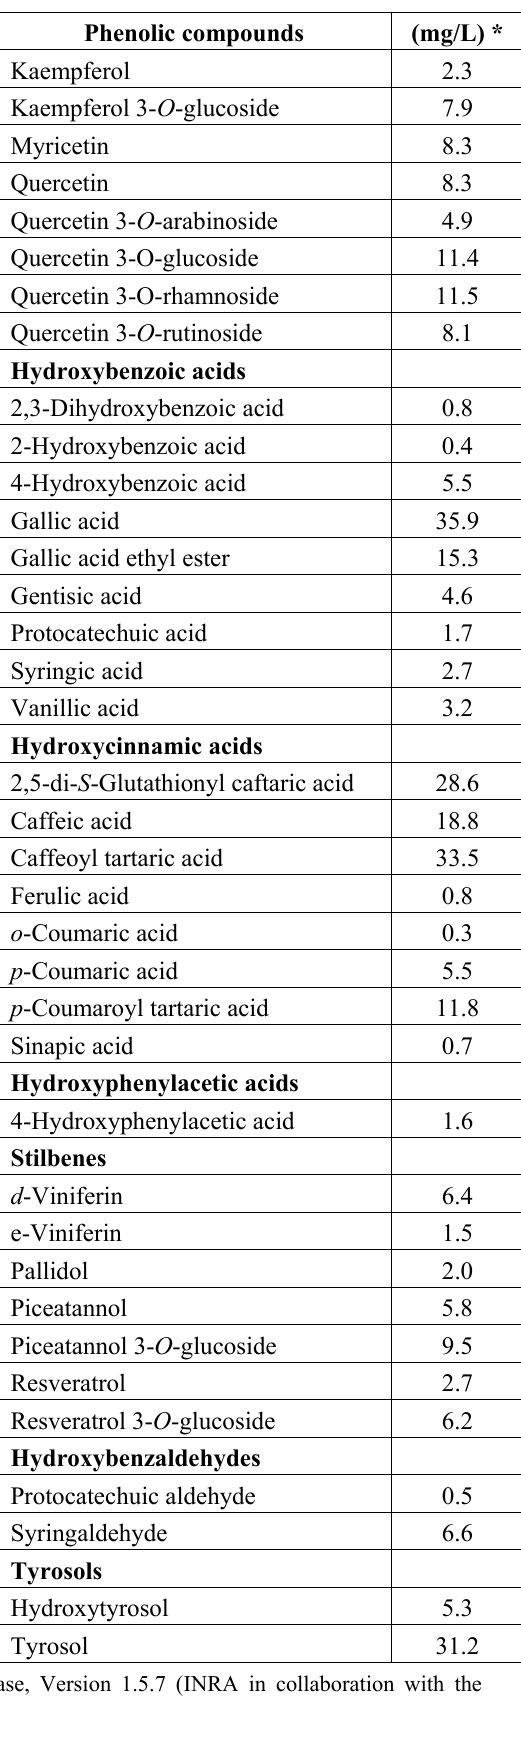
Table 1. Polyphenolic compounds in red